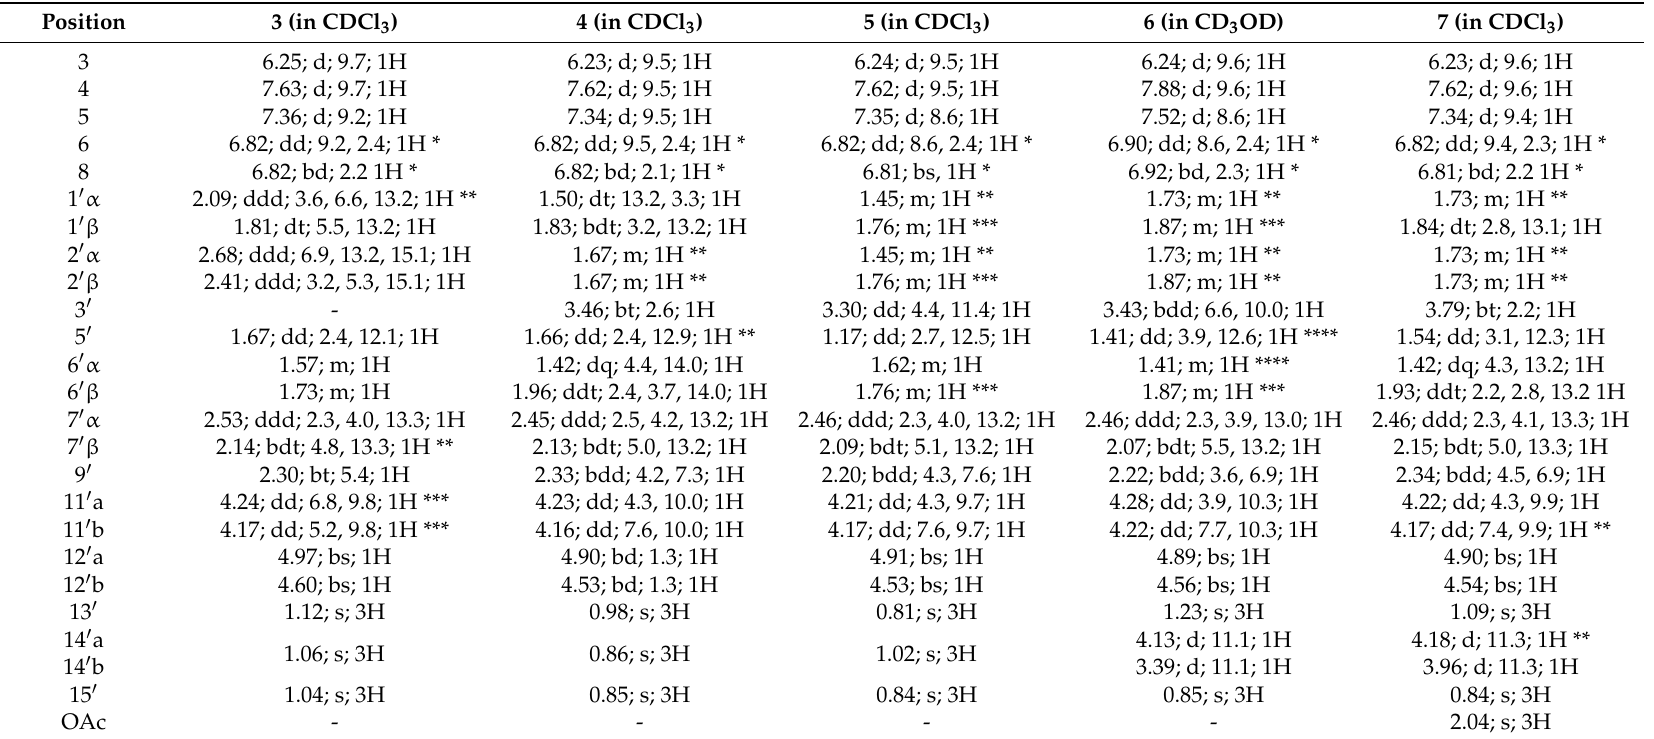
Table 1. 1 H-NMR data of compounds 3 – 7 (400 MHz, δ in ppm, m, J in